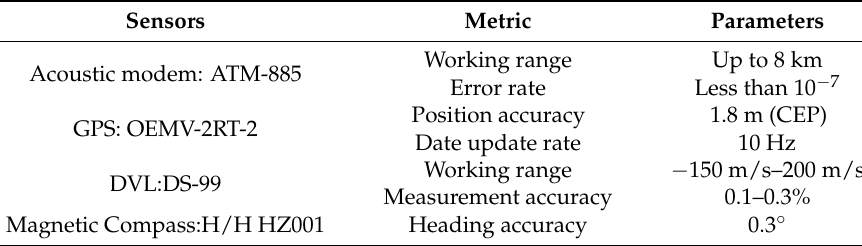
Figure 3. Sensors and computer employed in this test. Table 4. The parameters of employed